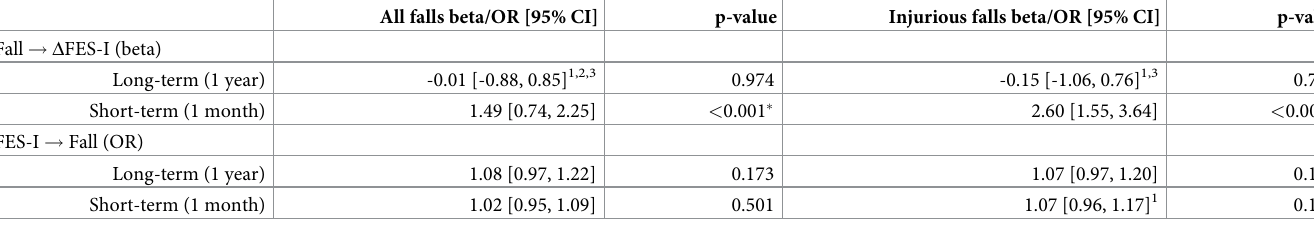
Table 2. Relation between falling and concern about falling over long-term and short-term intervals. All falls beta/OR [95% CI] p-value Injurious falls beta/OR [95% CI]